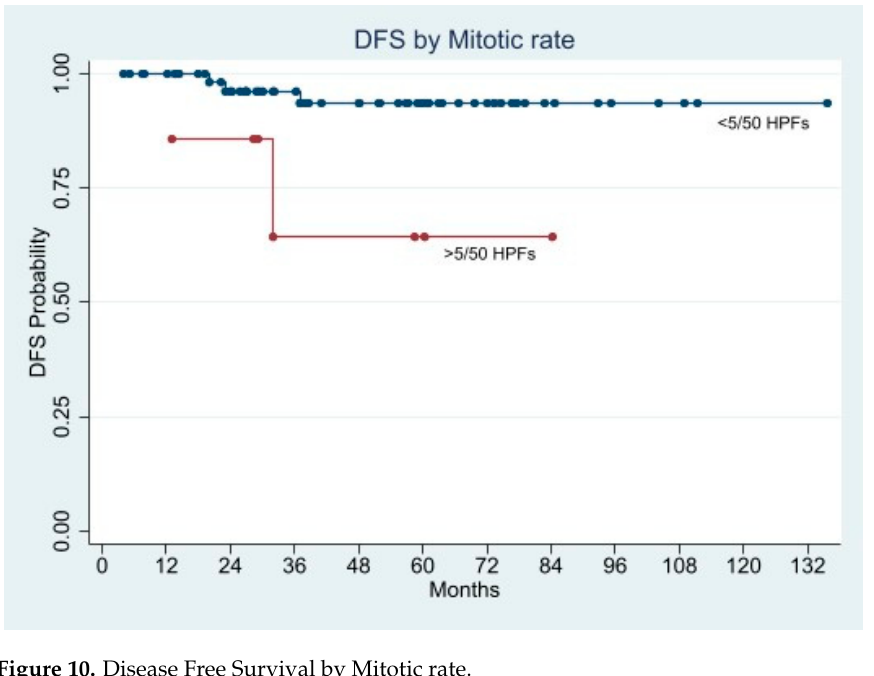
Figure 10. Disease Free Survival by Mitotic rate.